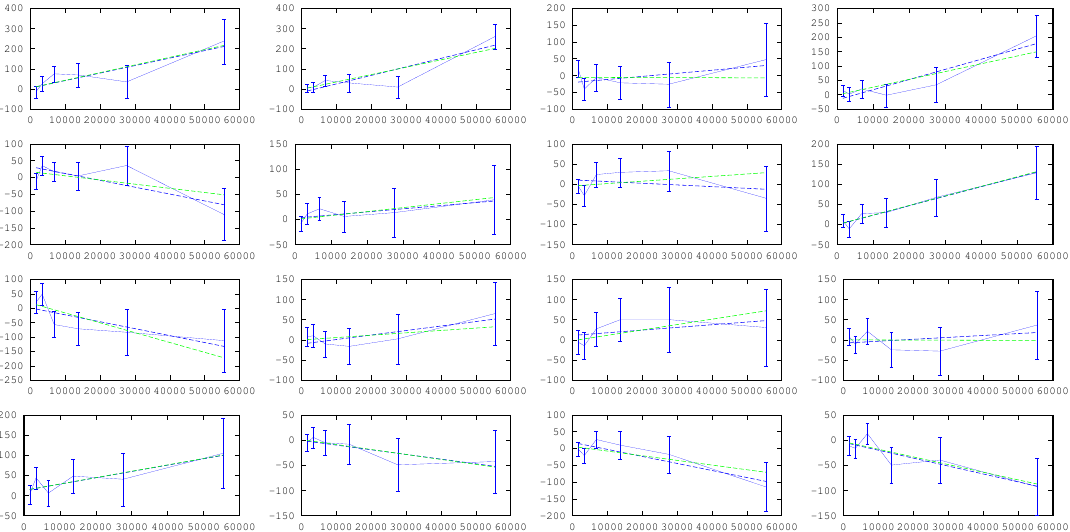
Figure 3. Deviations v l,c ( x, y ) ˜ e l,c ( x, y ) over ˜ e l,c ( x, y ) for the red channel. Note that the 7th stop saturated the red channel and is − thus not included. Dashed lines are fitted linear FPN models (blue LS, green weighted LS of Equation 6).